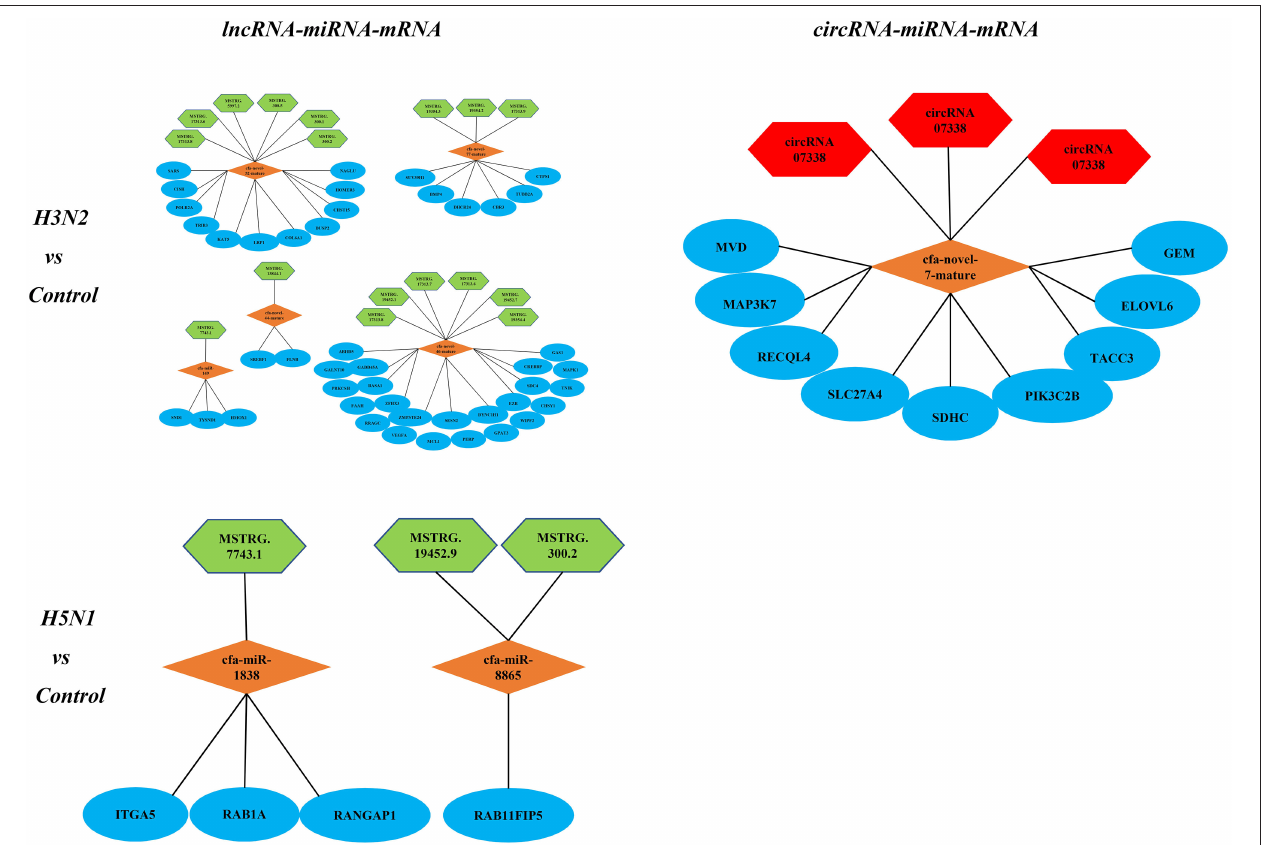
FIGURE 6 | KEGG pathways associated with the lncRNA-miRNA-mRNA and circRNA-miRNA-mRNA regulatory networks; green represents lncRNAs, red represents circRNAs, orange represents miRNAs, and blue represents mRNAs.